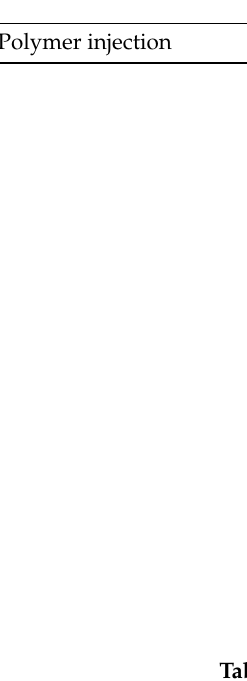
Table 15. Polymer injection energy and material consumption data [57]. Process.